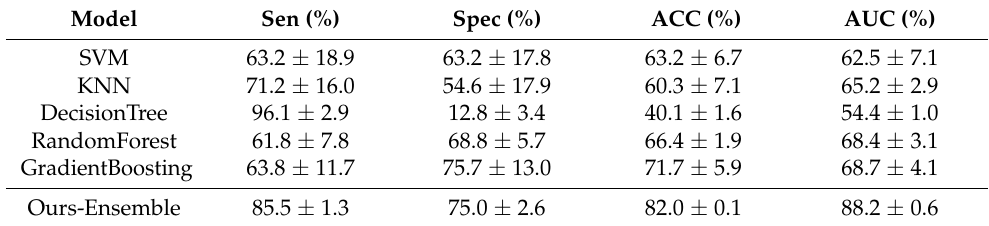
Table 7. Performance of machine learning methods in the validation